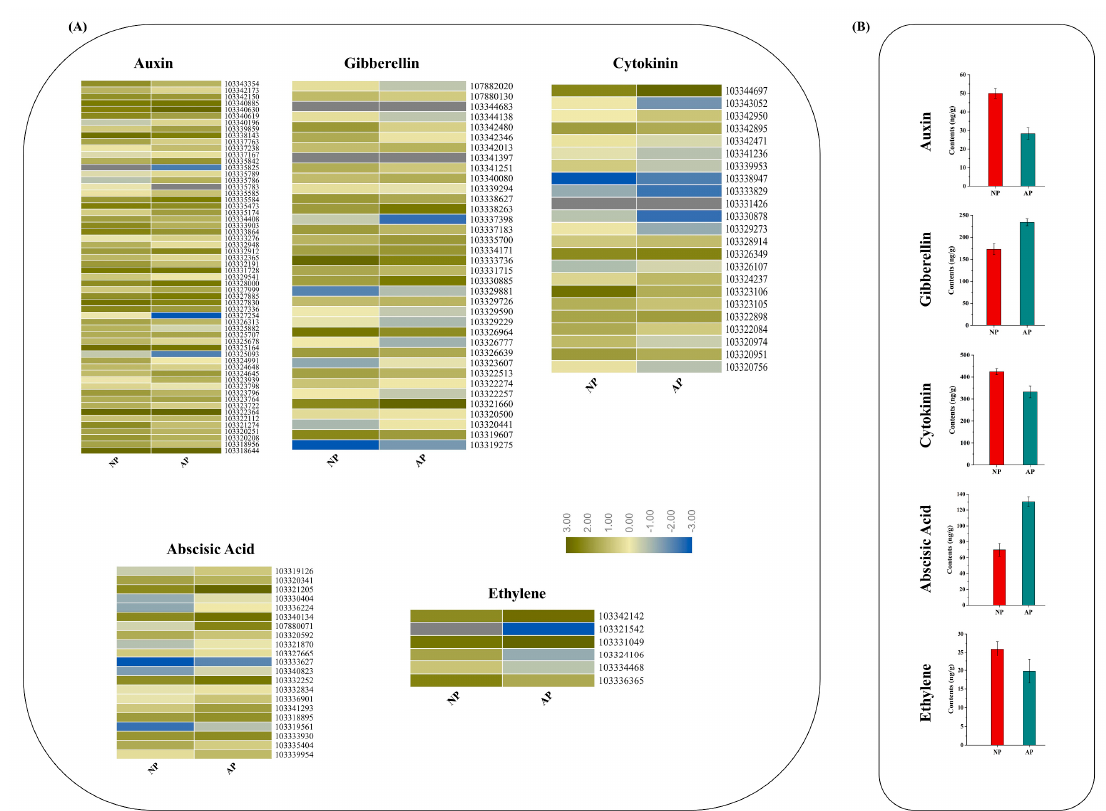
Figure 5. Expression profiles of the DEGs involved in plant hormones and signaling transduction pathway ( A ) Heatmap shows the expression of DEGs in normal and abortive pistils associated with di ff erent hormones like auxin, gibberellin, cytokinin, abscisic acid and ethylene. The bar represents the expression level of each gene as indicated by blue (lower expression) and dark yellow (higher expression). ( B ) Endogenous hormone contents between normal and abortive pistils. Three independent samples were collected for hormone